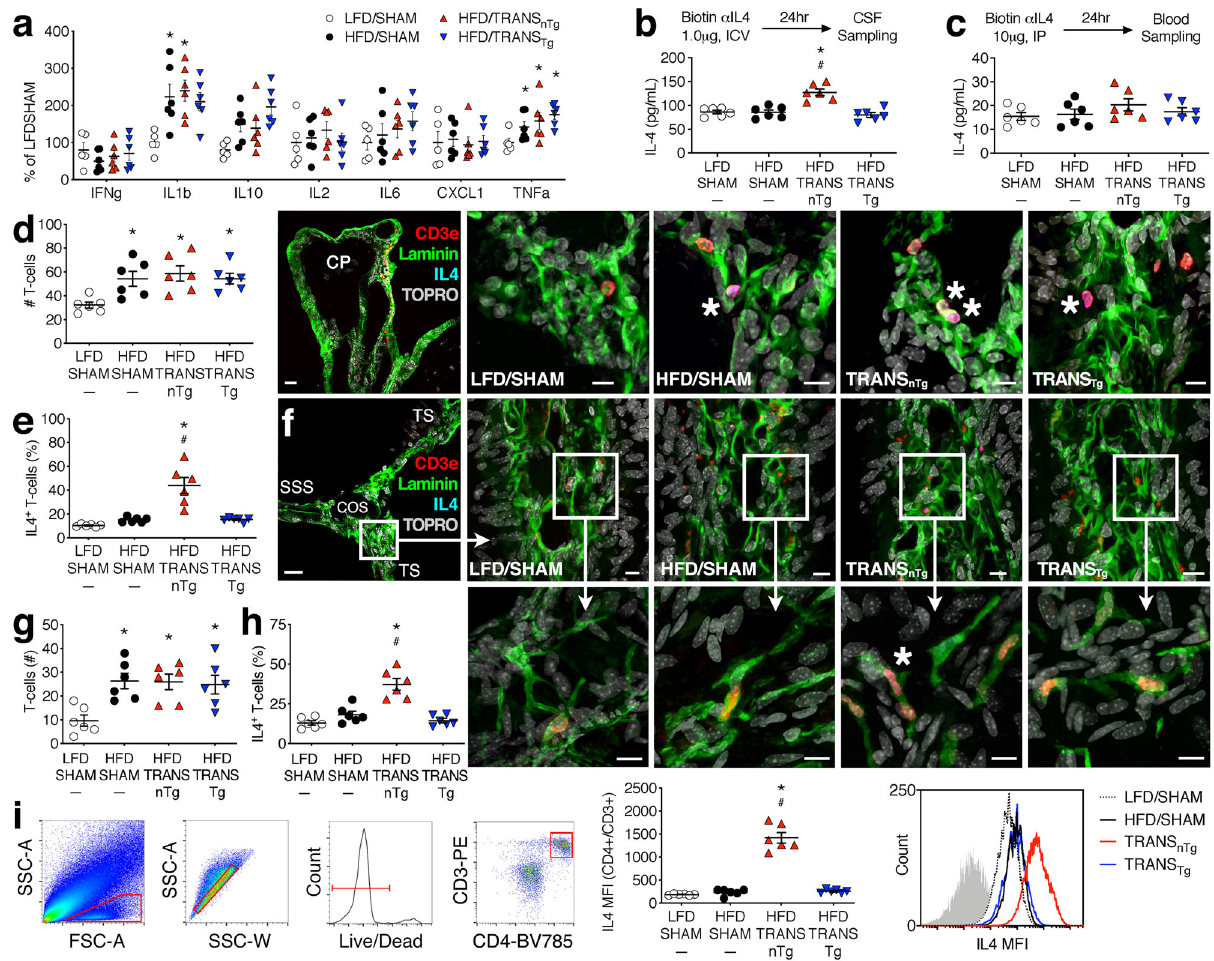
Fig. 5 Surgical increases in subcutaneous fat increase IL4 in CNS T cells via beige adipose-dependent mechanisms. a Multiplex analysis of serum cytokines after 4 wk on a low-fat or high-fat diet (LFD, HFD), with the sham operation (SHAM) or SAT transplantation from a nontransgenic (TRANS nTg ) or transgenic donor (TRANS Tg ) during week 2 (LFD/SHAM, n = 5; all other groups, n = 6). Symbols represent individual mice and lines show mean ± sem (applies to a , i ). b Top panel shows schematic of in vivo antibody capture assay for detection of interleukin-4 (IL4) in cerebrospinal fl uid (CSF). Graph (bottom) shows beige fat-dependent increases in CSF IL4 ( n = 6 mice/condition). c Top panel shows in vivo capture approach for analysis of circulating IL4. Graph (bottom) shows quanti fi cation of serum IL4 by ELISA ( n = 6 mice/condition). d Graph shows an increased T-cell number in the choroid plexus with dietary obesity ( n = 6 mice/condition; applies to d – h ). Micrographs (right) show representative labeling for laminin, CD3e, and biotinylated IL4 capture antibody in the choroid plexus (CP) following ICV delivery. Scale bar for anatomical reference micrograph (left) = 20 μ m; for group comparison micrographs, scale bar = 10 μ m. e Increased numbers of IL4 + T cells in the choroid plexus of TRANS nTg mice. f Meningeal CD3e + cells were quanti fi ed along laminin-labeled basement membranes in the transverse sinus (TS) adjacent to the con fl uence of sinuses (COS) and posterior to the superior sagittal sinus (SSS). Scale bar for anatomical reference (left) = 20 μ m; for group comparison micrographs, scale bar = 10 μ m. g Meningeal T-cell number increases with obesity, irrespective of SAT transplantation. h Increased uptake of IL4 capture antibody in meningeal CD3e + T cells after SAT transplantation from a nontransgenic (TRANS nTg ) but not an Adiponectin cre /PRDM16 fl / fl transgenic donor (TRANS Tg ). Micrographs (right) show immuno fl uorescence detection of biotinylated anti-IL4 in CD3e + lymphocytes. i Gating strategy for analysis of endogenous IL4 expression in CNS T cells (CD4 + /CD3e + ). Graph (middle) shows increased intracellular IL4 fl uorescence in T cells from TRANS nTg mice, relative to all other groups ( n = 6 mice/condition). Histograms (right) show IL4 mean fl uorescence intensities (MFI) for representative samples in each condition (isotype control shown in gray). For all graphs, white circles represent LFD/SHAM; black circles, HFD/SHAM; red triangles, TRANS nTg ; inverted blue triangles, TRANS Tg . For a – i , one-way ANOVA; * p < 0.05 relative to nTg/ LFD; # p < 0.05 relative to nTg/HFD, determined by Tukey ’ s multiple comparison test or Dunnett ’ s T3 for heterogeneity of variance. For data, statistics, and exact p -values, see Source Data File